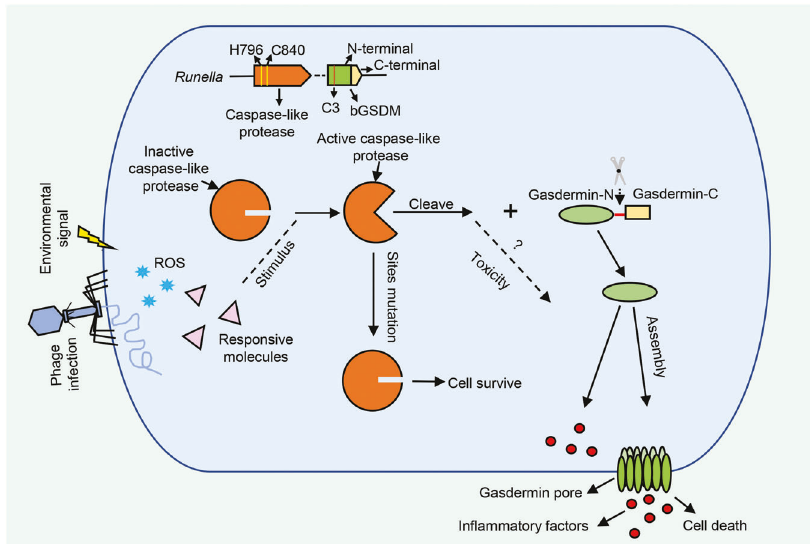
Fig. 1 Mechanism of bGSDM-mediated cell death. On recognition of external stimuli, such as phage and environmental matters, the caspase-like proteases are activated. Co-expression of bGSDM and their cognate proteases leads to bacterial growth arrest and membrane permeabilization. bGSDM palmitoylation (C3 in red line) is essential for particularly strong toxicity in Runella system. Mutations of the catalytical residues (H796 and C840 in yellow lines) in caspase-like protease abolished cellular toxicity and blocked cell death. The autoinhibited bGSDM was cleaved by caspase-like protease into N- and C-terminal domains. The active N-terminal domains are oligomerized to form bGSDM pore spanning the membrane that can permeabilize liposomes and thereby releasing in fl ammatory factors, and consequently leads to cell